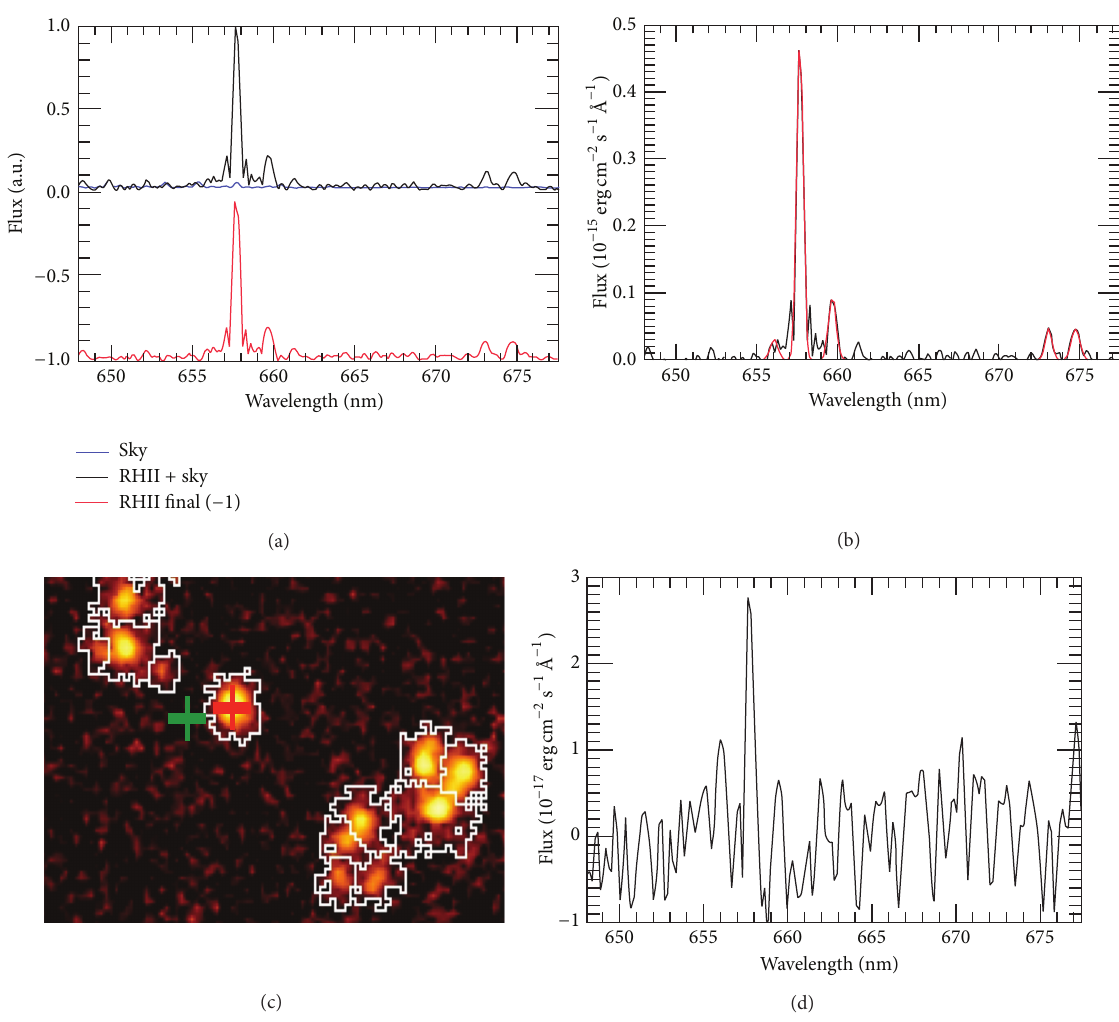
Figure 4: (a) Example of the sky subtraction for the spectrum of a bright pixel (1h36 m 54.1s; +15 ∘ 46m10.8 s). (b) Example of a Gaussian fit on the spectrum of a bright pixel. (c) Close-up on the contours map of NGC 628 selected by HIIphot; the field of view is 1.5 󸀠 × 1 󸀠 . The red cross identifies the position of the bright pixel used for the previous sky subtraction and Gaussian fit examples. The green cross identifies the pixel with H 𝛼 in emission at ∼ 2 𝜎 limit of detection. (d) Example of the spectrum of a 1.1 arcsec 2 pixel with H 𝛼 in emission at ∼ 2 𝜎 limit of